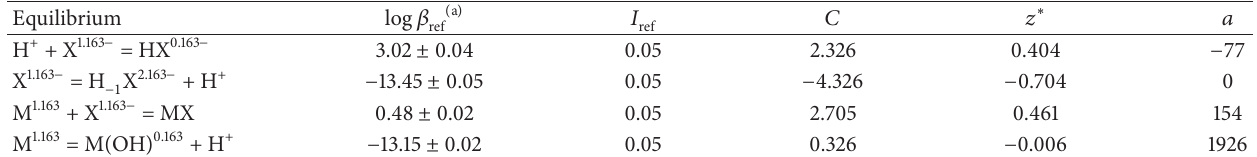
Table 7: Stability constants of S strength and temperature (by (8)–(11)).